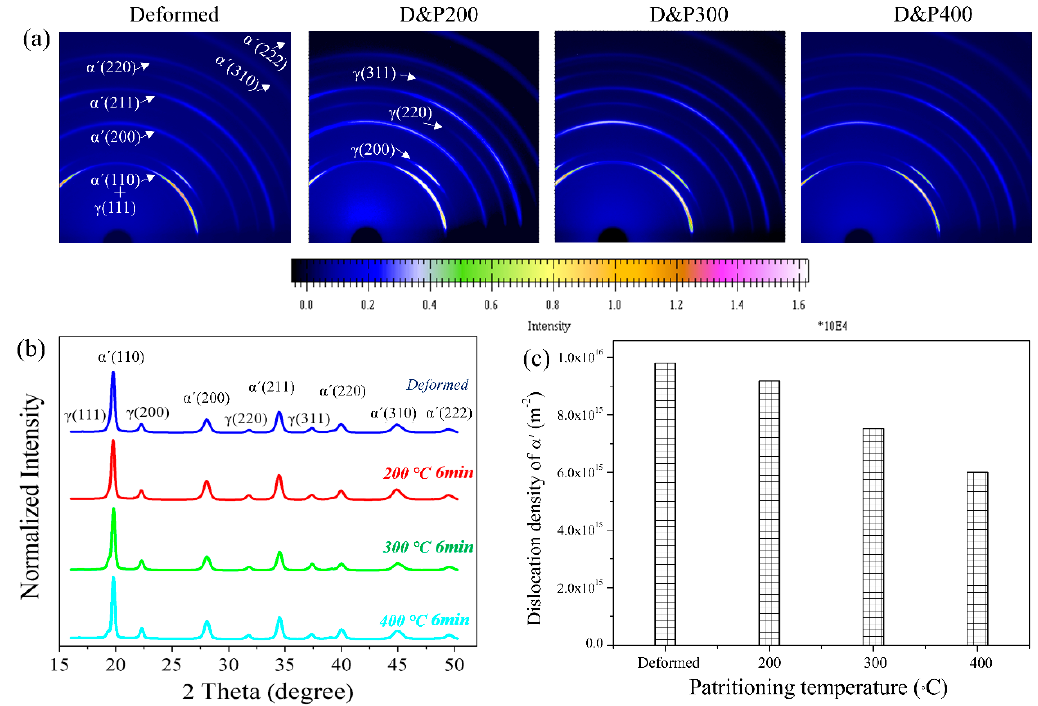
Figure 5. ( a ) 2D synchrotron X-ray diffraction patterns of D&P steels processed at different partitioning temperatures. Images have been colorized with high contrast to highlight the Debye diffraction rings. ( b ) 1D synchrotron X-ray diffraction profiles (intensity-2 theta curves) converged by ( b ) 1D synchrotron X-ray di ff raction profiles (intensity-2 theta curves) converged by 2D di ff raction patterns. ( c ) The dislocation density of the martensitic matrix in D&P